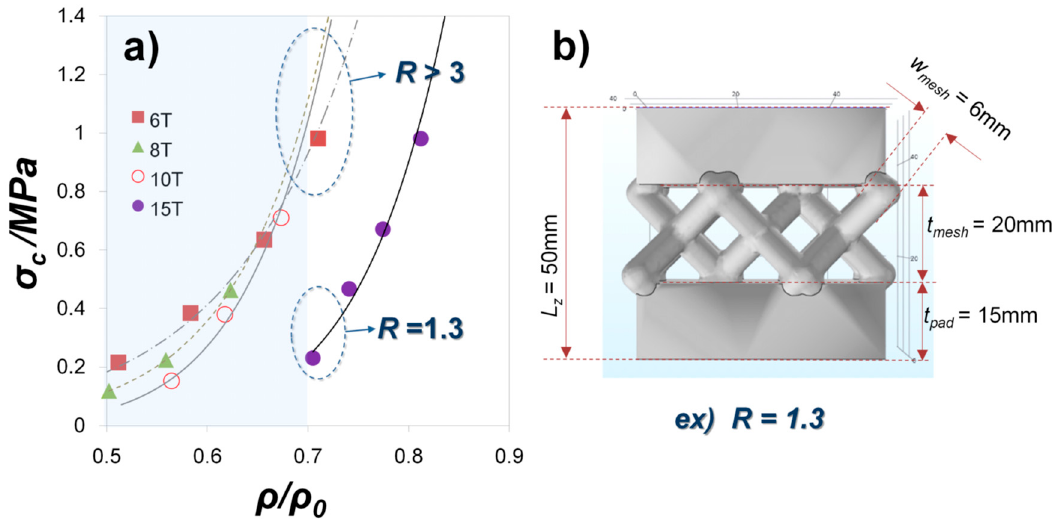
Figure 4. ( a )-Compressive strength ( σ C ) as a function of volume ratio ( ρ / ρ 0 ) with different pad (bulk) thickness ( t pad = 6 T, 8 T, 10 T and 15 T) and ( b )-thickness ratio of mesh and bulk (R = t mesh / t pad ).